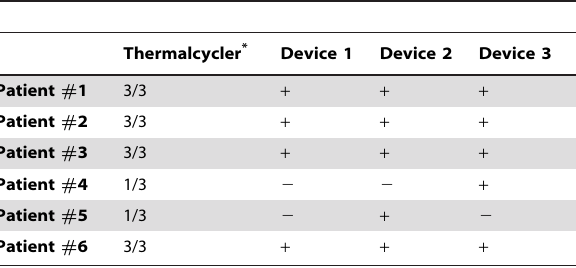
Table 4. Amplification of HIV-1 DNA/RNA from whole blood in NINA heaters.